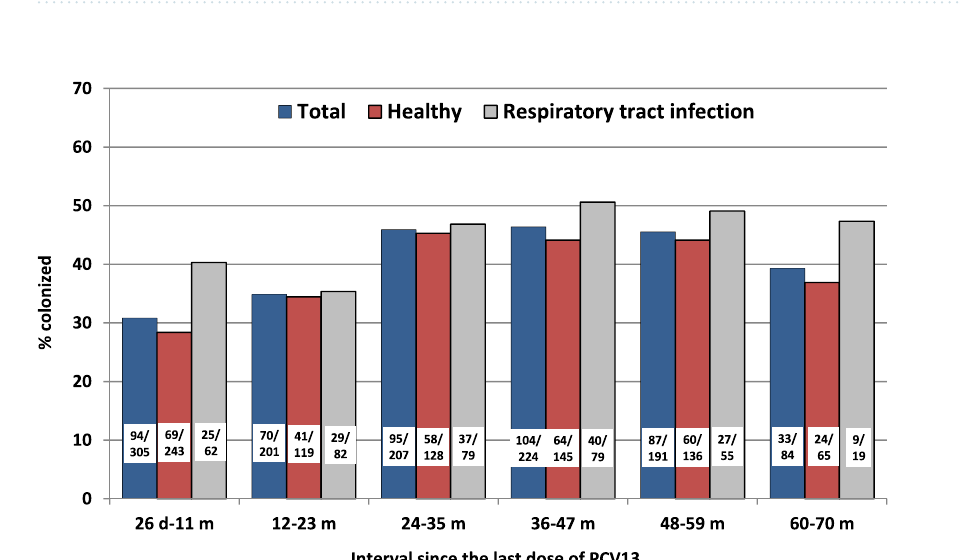
Table 2. Characteristics of the study population. a IQR: interquartile range. b Ν/Α: not available.